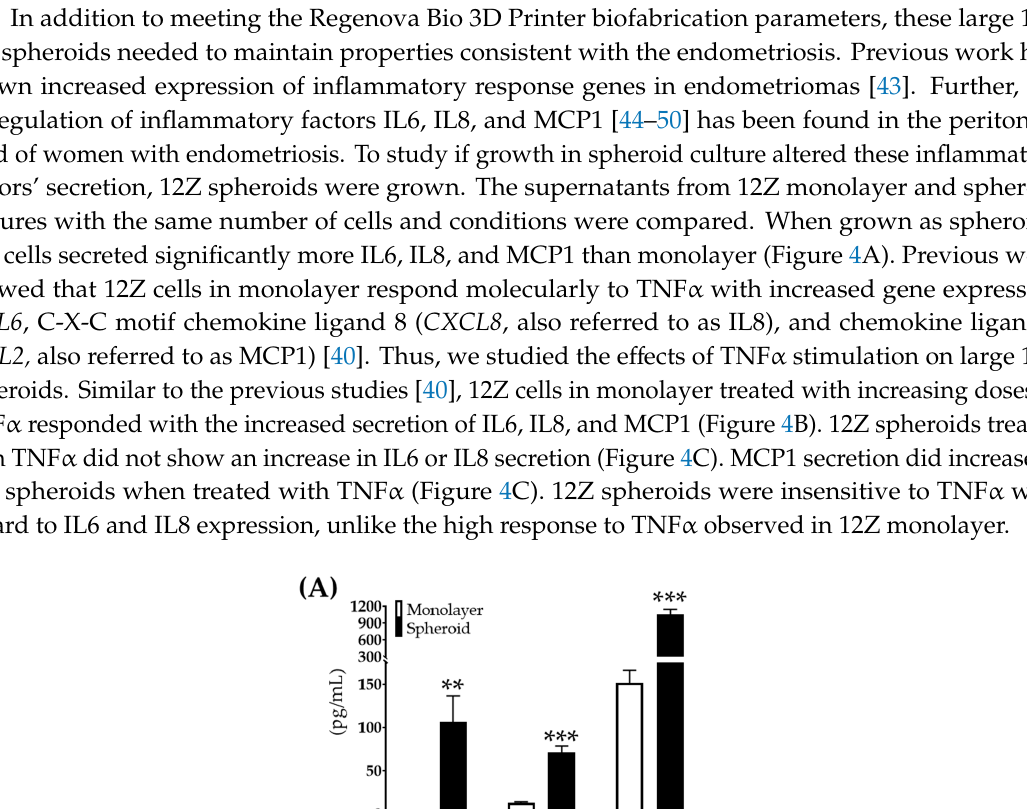
Table 1. Biofabrication conditions for cell